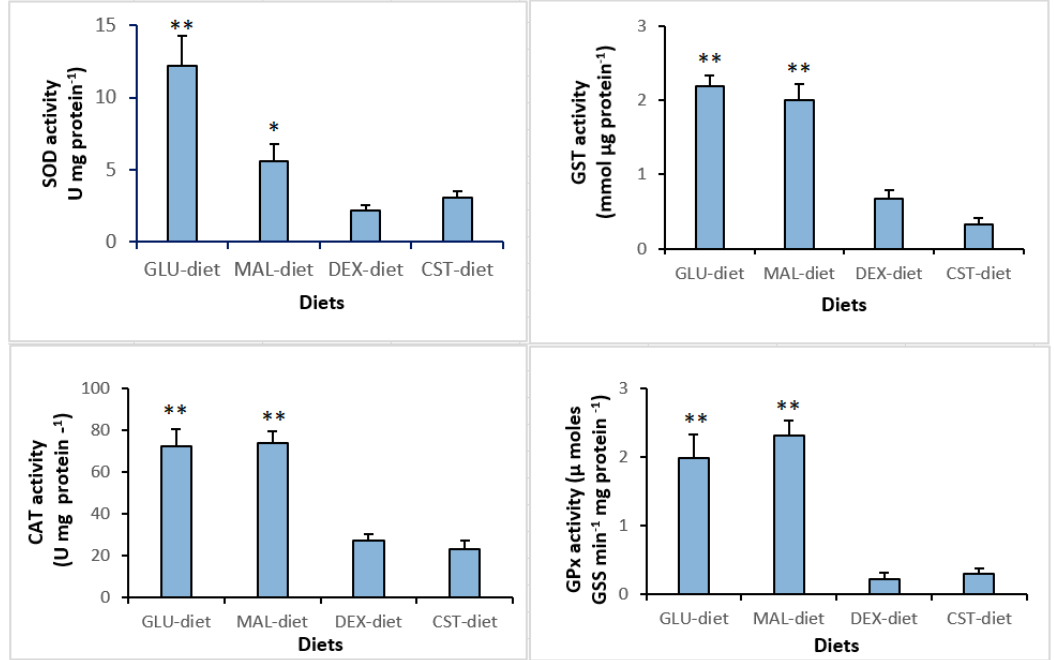
Figure 1. Specific activities of superoxide dismutase (SOD), glutathione S-transferase (GST), catalase (CAT), and glutathione peroxidase (GPx) in the livers of juvenile Nile tilapia O. niloticus fed on experimental diets. In each graph, bars and whiskers represent the means + SEM. Values represent the mean of six measurements ( n = 6). Significantly di ff erent values are indicated by asterisks (* p < 0.05; ** p < 0.01).